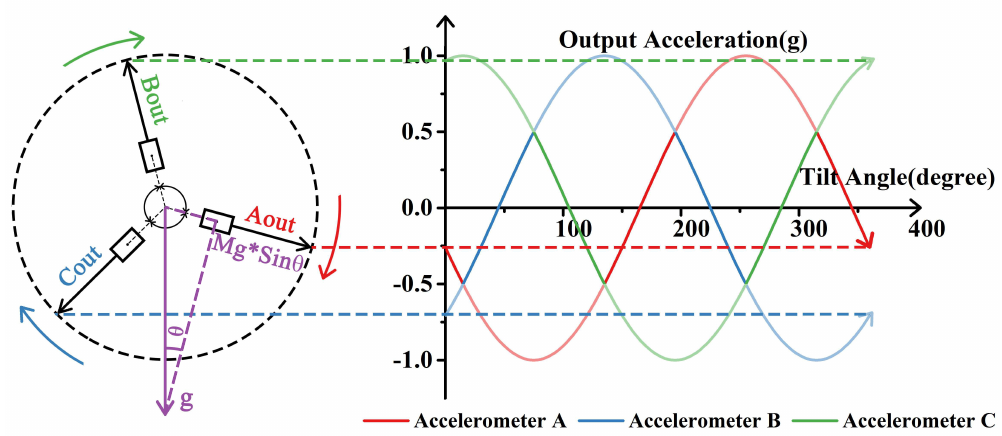
Figure 1. Schematic drawing of tilt measurement based on three accelerometers and simulated output of each accelerometer as